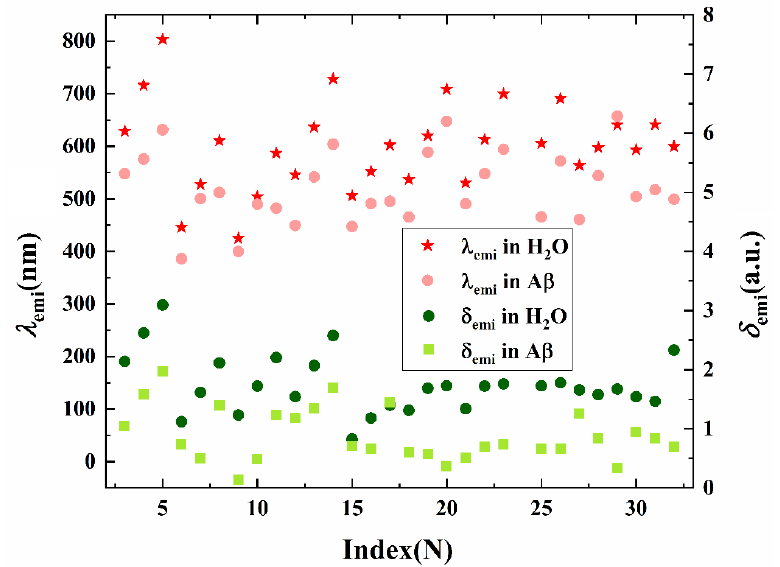
Figure 8. The fluorescent wavelength λ emi (the left vertical axis) and emission strength δ emi (the right vertical axis) for probes 1 – 32 in H 2 O and A β . Table 2. Fluorescent wavelength λ emi (nm), Stokes shift (nm), fluorescent lifetime τ (ns), and the transition nature of selected probes in H 2 O and in A β . λ (nm) represent the shift in fluorescent wavelength of these probes in A β compared to the case in H 2 O.